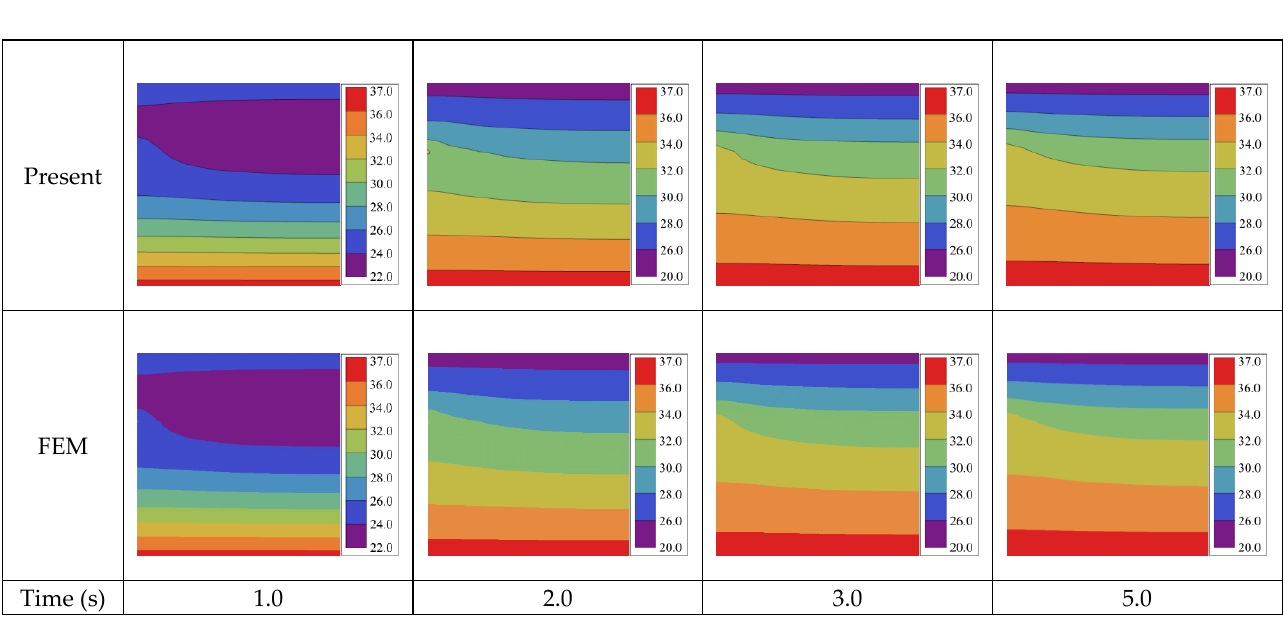
Figure 4. Temperature distribution (°C) for Case 1 on bi-layered transient heat conduction with a point heat source.